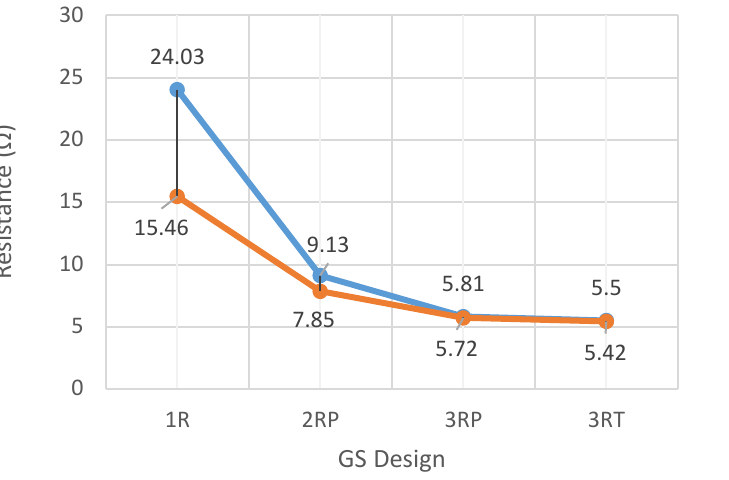
Figure 14. GR vs. GS design in S2.